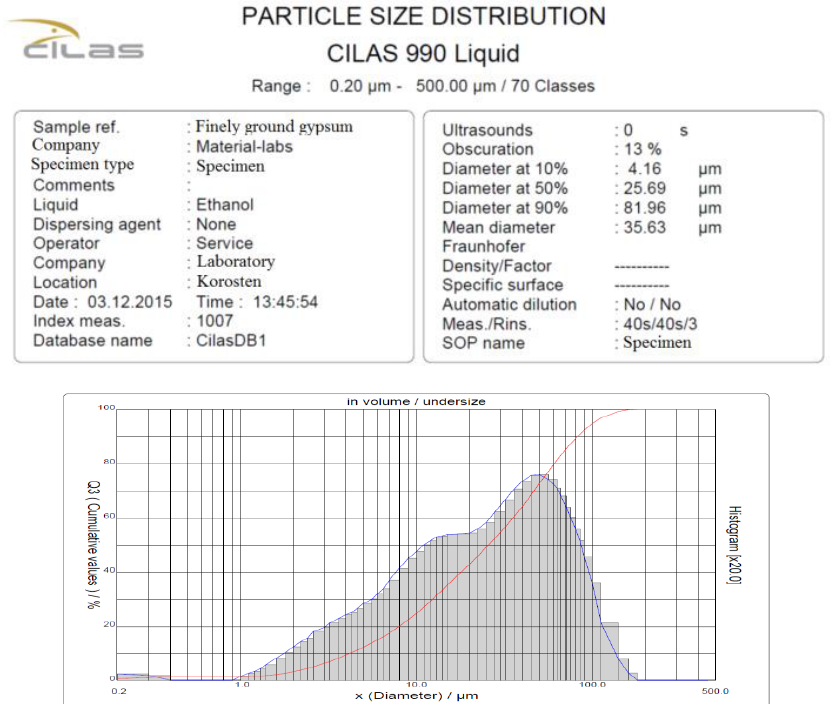
Figure 4. Differential particle sized distribution curve for finely ground